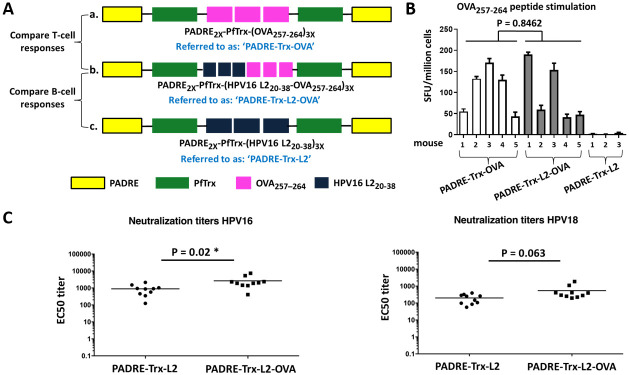
OVA-specific T-cell epitopes and HPV16 L2-specific B-cell epitopes can be combined in a single construct without compromising each other’s immunogenicity.(A) Antigen structure. Design a: Construct PADRE-Trx-OVA only containing the T-cell epitope OVA257-264. Design b: Construct PADRE-Trx-L2-OVA bearing both the T-cell epitope OVA257-264 and the B-cell epitope HPV16 L220-38. Design c: Construct PADRE-Trx-L2 only containing the HPV16 L220-38 B-cell epitope. (B) Influence of L2 B-cell epitopes on the induction of OVA-specific CTL responses. Numbers of IFN-γ spots per 106 splenocytes are compared in three groups of mice immunized with PADRE-Trx-OVA, PADRE-Trx-L2-OVA or PADRE-Trx-L2 (negative control). Splenocytes were stimulated with the OVA257-264 peptide. Shown are the mean and SD of triplicate values on each mouse. (C) Influence of OVA epitopes on the induction of anti-HPV16 and anti-HPV18 neutralizing antibodies. Sera were collected one month after the last immunization with PADRE-Trx-L2 or PADRE-Trx-L2-OVA (10 mice/group) and analyzed against HPV16 and HPV18 pseudovirions using the L1-PBNA. Each symbol represents the neutralization titer (EC50) of an individual animal; geometric means of the titers for each group are indicated by horizontal lines. P-value ≤ 0.05 was considered as significant (*).